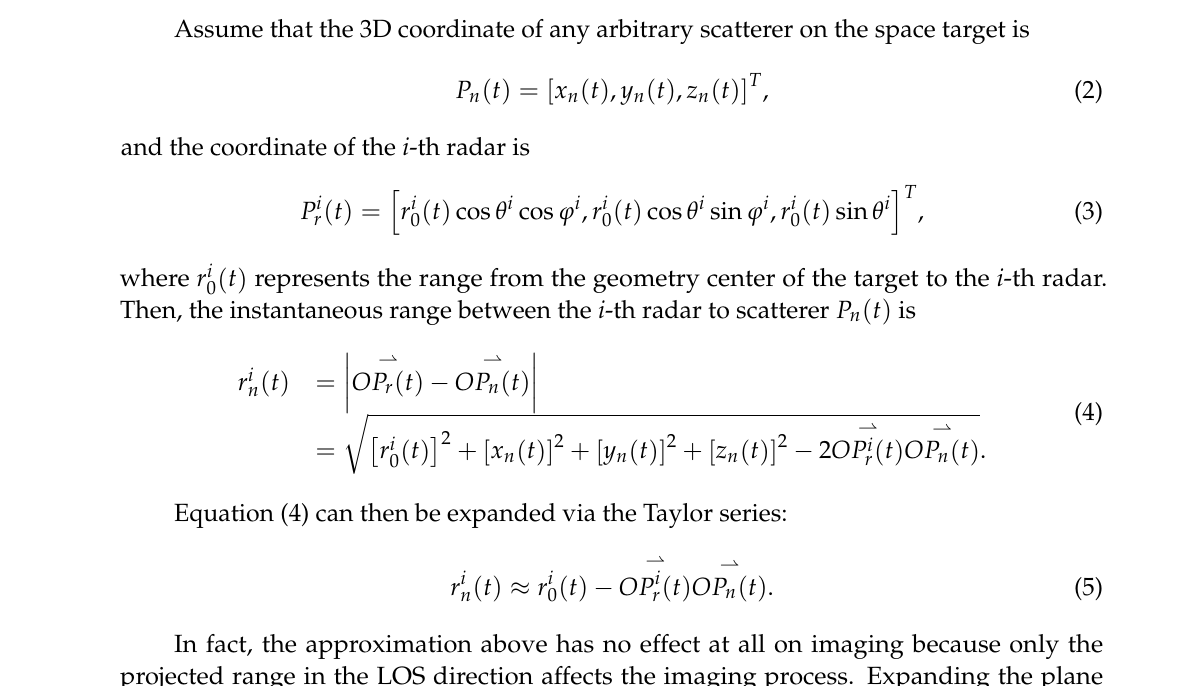
Figure 1. ISAR imaging geometry of the space target: ( a ) the observed geometry of the space target; ( b ) a diagram for constructing the ISAR imaging plane.